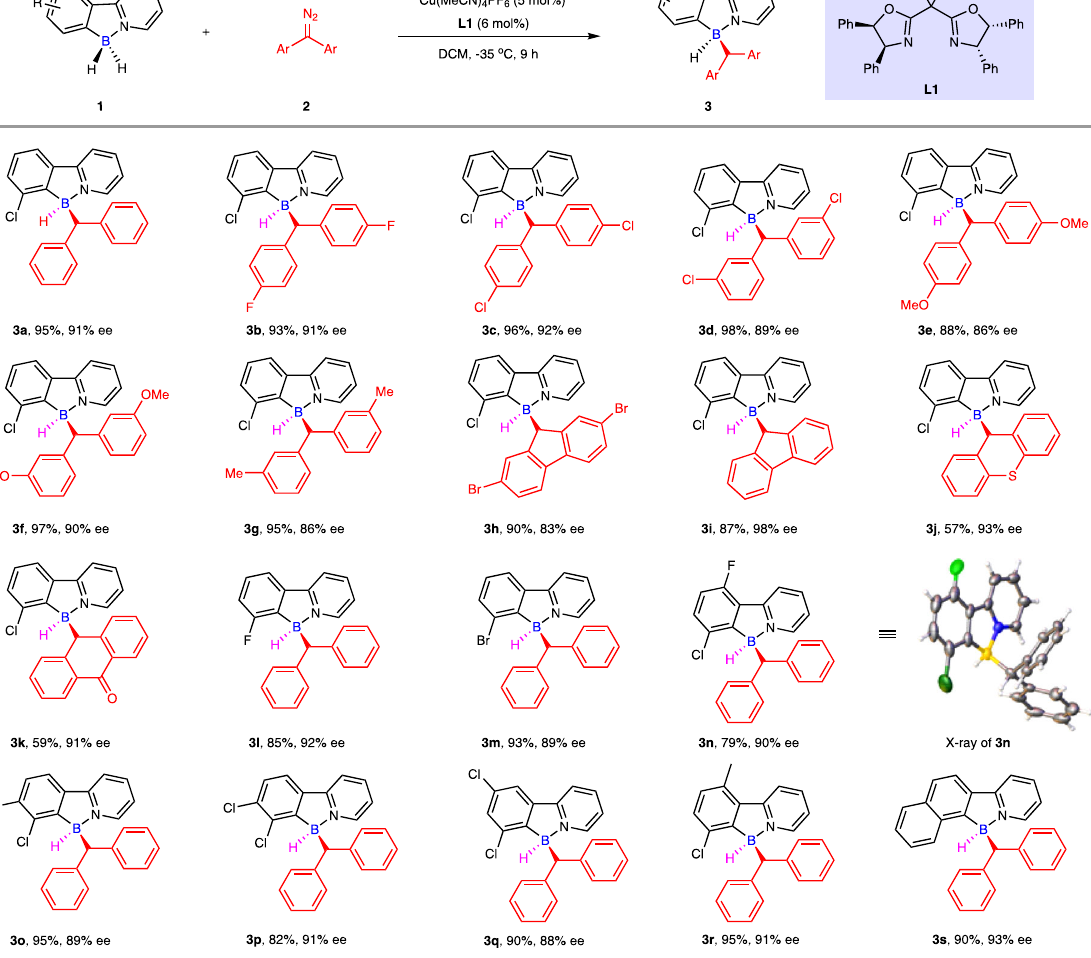
Fig. 5 Scope of enantioselective B − H insertion with symmetric diazo compounds. Conditions: a 2-arylpyridine-borane 1 (0.1 mmol, 1.0 equiv), symmetric diaryl diazomethane 2 (0.12 mmol, 1.2 equiv), Cu(MeCN) 4 PF 6 (5 mol%), L1 (6 mol%), DCM (1 mL) at -35 °C for 9 h. b Isolated yield. NATURE COMMUNICATIONS| (2022) 13:2624